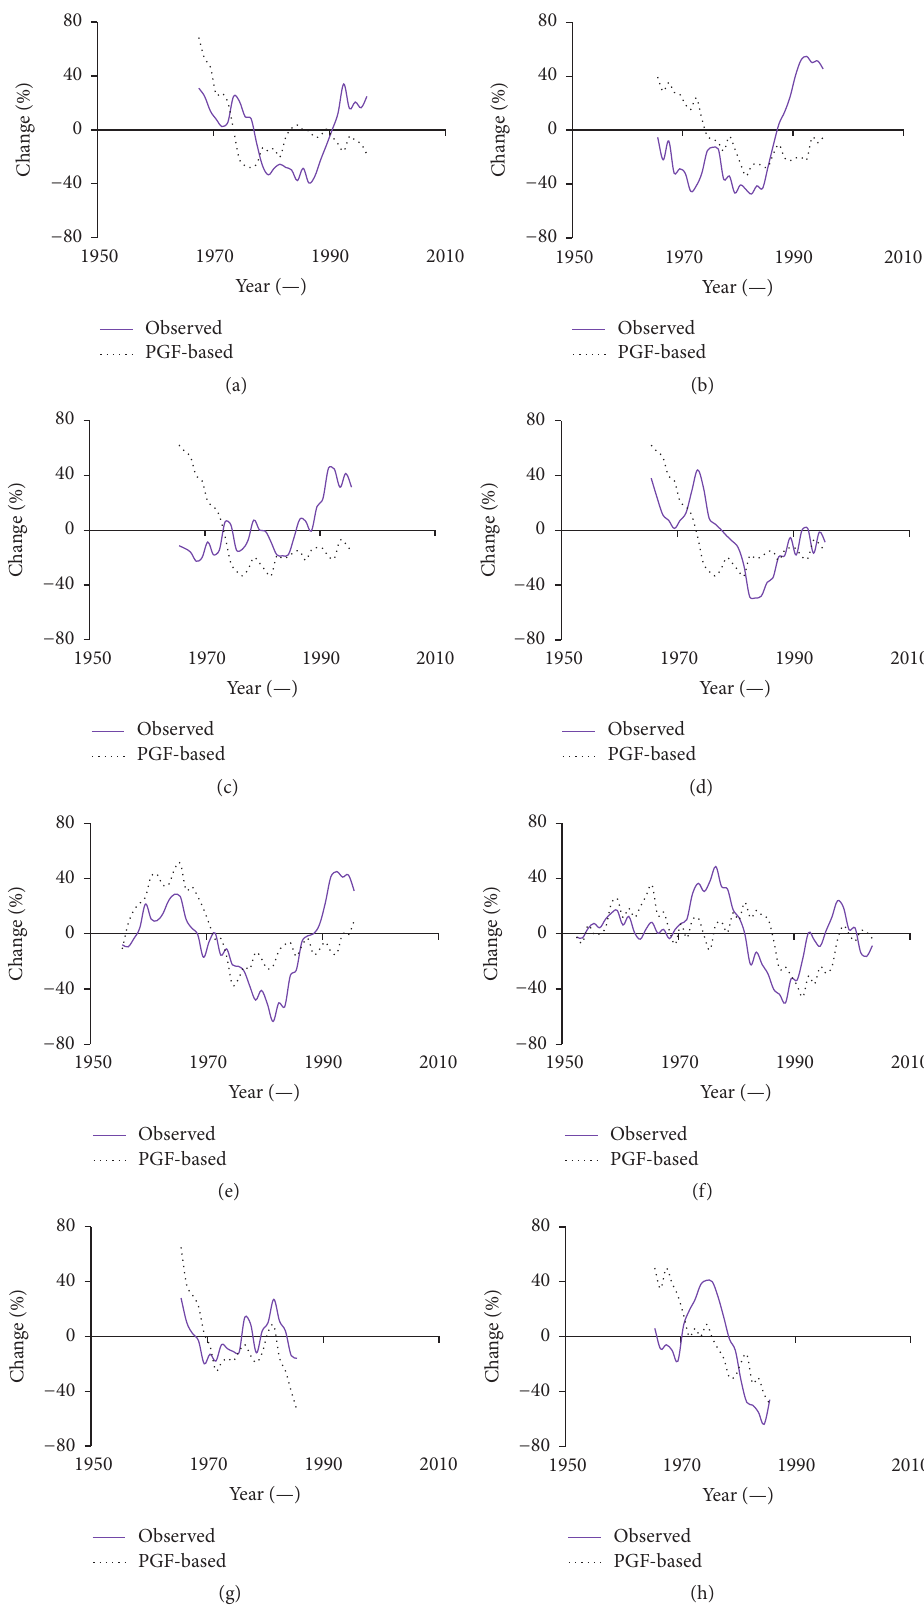
Figure 3: NAIM decadal changes (%) in the top fifteen rainfall events in each year based on observed and PGF-based series at stations (a) 1, (b) 2, (c) 3, (d) 4, (e) 5, (f) 6, (g) 7, and (h)